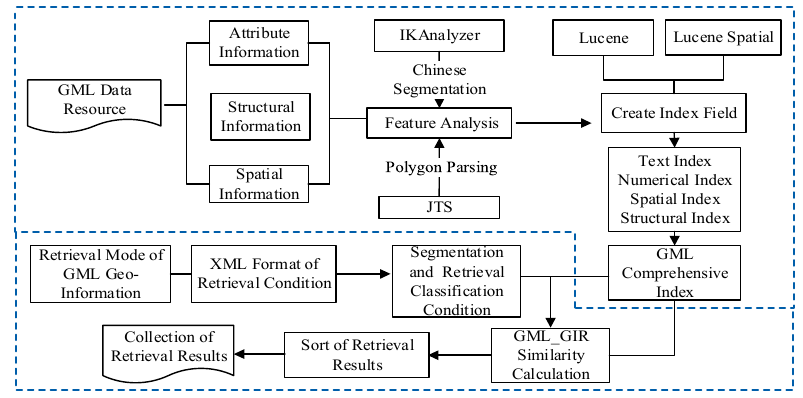
Figure 4. GML geo-information retrieval.